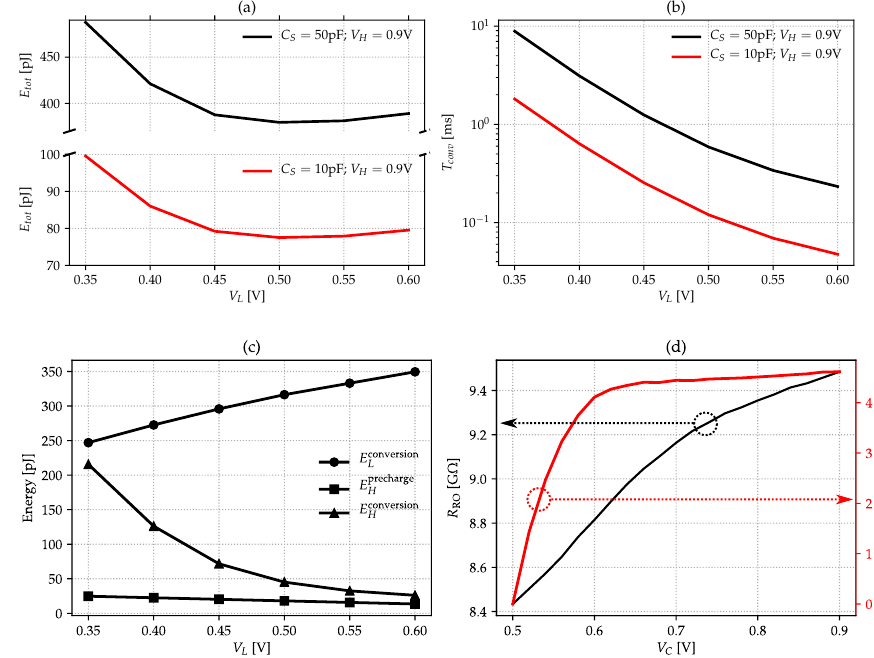
Figure 8. Key design parameters: ( a ) total energy per conversion E tot as function of V L for fixed V H = 0.9 V; ( b ) energy balance as from Equation (18) as function of V L for C S = 50pF and fixed V H = 0.9 V; ( c ) conversion time T conv as function of V L for fixed V H = 0.9 V; ( d ) R RO and ∆ t as function of V C .